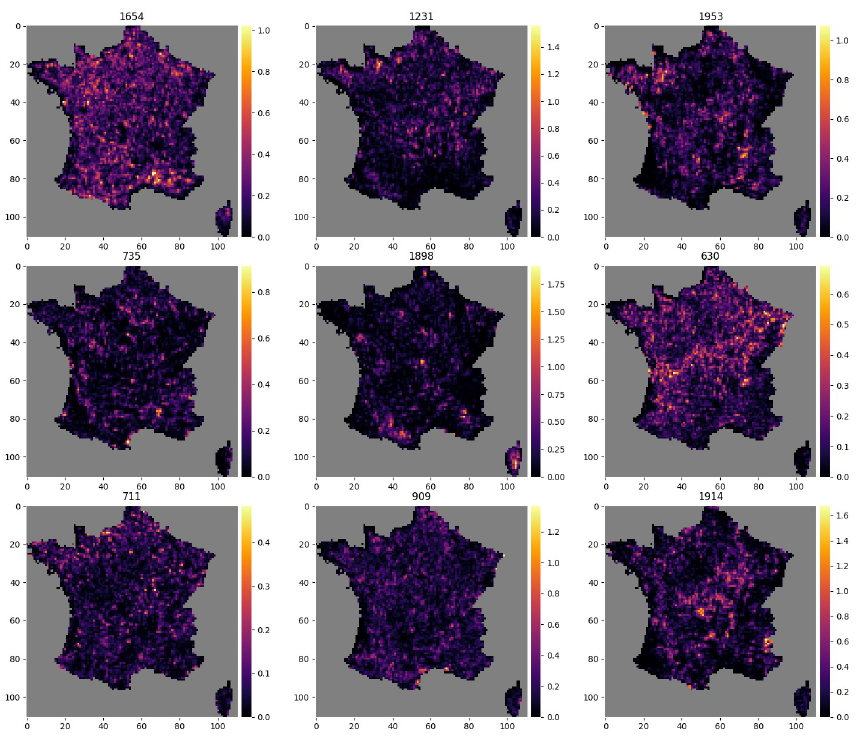
Fig 11. Activations maps that do not highlight a particular geographical shape. Example of 9 activation maps, for 9 different neurons, among the 2048 neurons of the final layer of the CNN-SDM that do not highlight a particular geographical shape. The number of the neuron is indicated above each